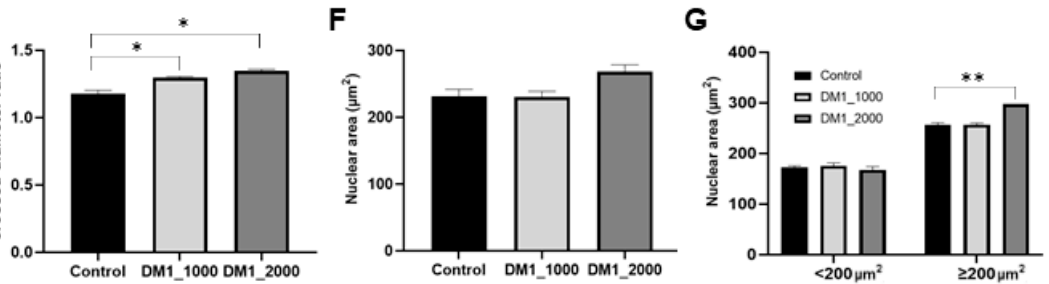
Figure 2. Nuclear profile of DM1 patient-derived and control fibroblasts. ( A ) The nuclear profiles of DM1 patient-derived and control fibroblasts were analysed using fluorescence microscopy and representative images are presented. Fibroblasts’ nuclei were stained with DAPI (blue). Quantitative evaluation of ( B ) deformed nuclei, ( C ) micronuclei, ( D ) nuclear circularity, ( E ) crossed diameter ratio, ( F ) nuclear area comparison between DM1 patient-derived fibroblasts (DM1_1000 and DM1_2000) and control group and ( G ) nuclear area of <200 µ m 2 and ≥ 200 µ m 2 . The quantitative data are presented as mean ± SEM and were obtained by analysing 100 cells per condition from four independent experiments. The statistical analysis was performed using one-way ANOVA followed by Tukey’s multiple comparison test used to compare between DM1_1000, DM1_2000 and the control groups. * p < 0.05, ** p < 0.01. Scale bar = 10 µ m. A.U.—arbitrary units; DM1—myotonic dystrophy type 1; SEM—standard error of the